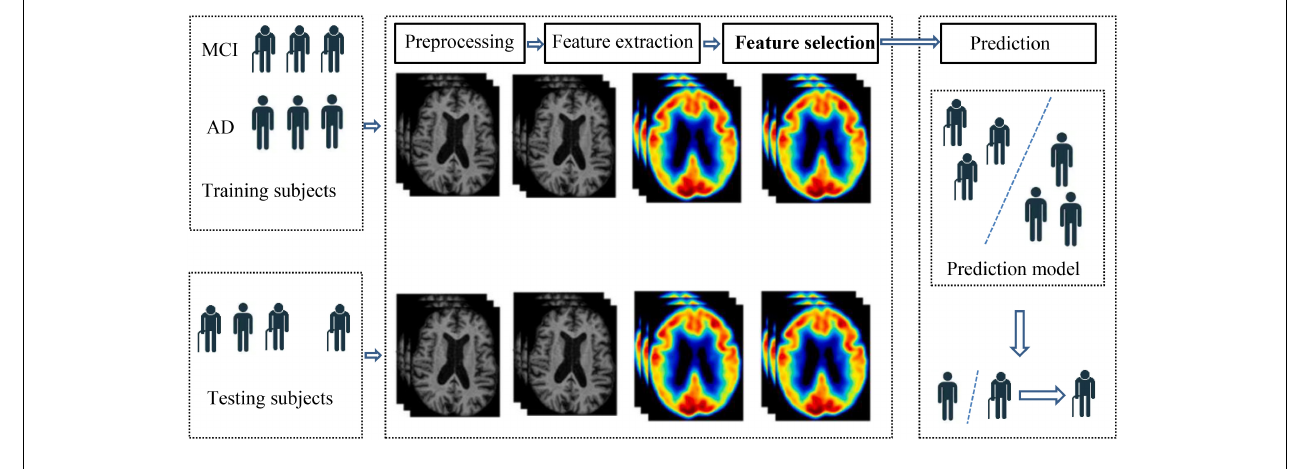
FIGURE 1 | General process of MCI/AD recognition.